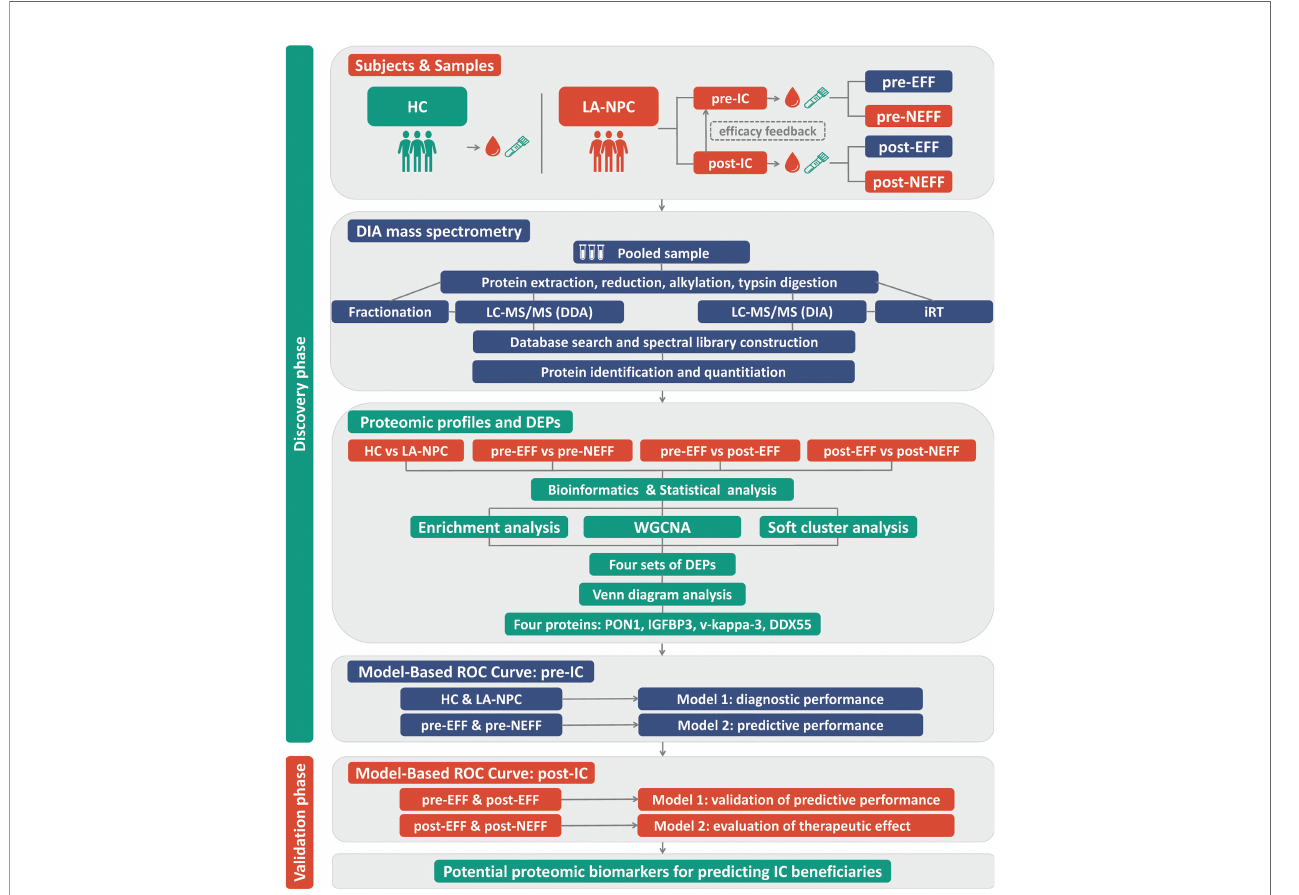
FIGURE 1 | Roadmap for identifying biomarkers for early identi fi cation of IC bene fi ciaries. HC, healthy control; LA-NPC, locoregionally advanced nasopharyngeal carcinoma; IC, induction chemotherapy; pre-EFF, pre-effective; pre-NEFF, pre-non-effective; post-EFF, post-effective; post-NEFF, post-non-effective; DDA, data- dependent acquisition; DIA, data-independent acquisition; DEPs, differentially expressed proteins; WGCNA, weighted gene co-expression network analysis; ROC, receiver operating characteristic.